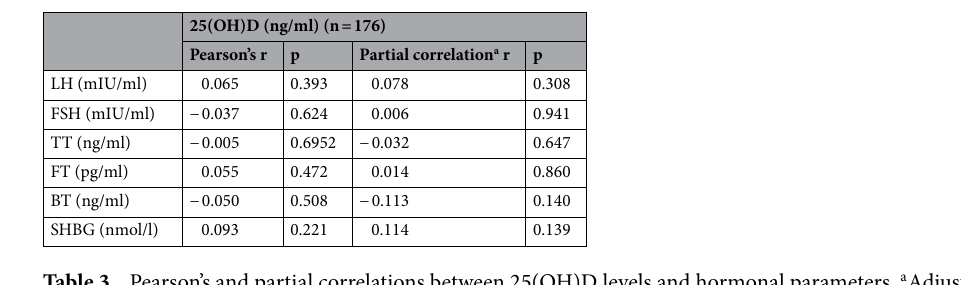
Table 3. Pearson’s and partial correlations between 25(OH)D levels and hormonal parameters. a Adjusted for age, BMI, WHR, alcohol intake and cigarettes